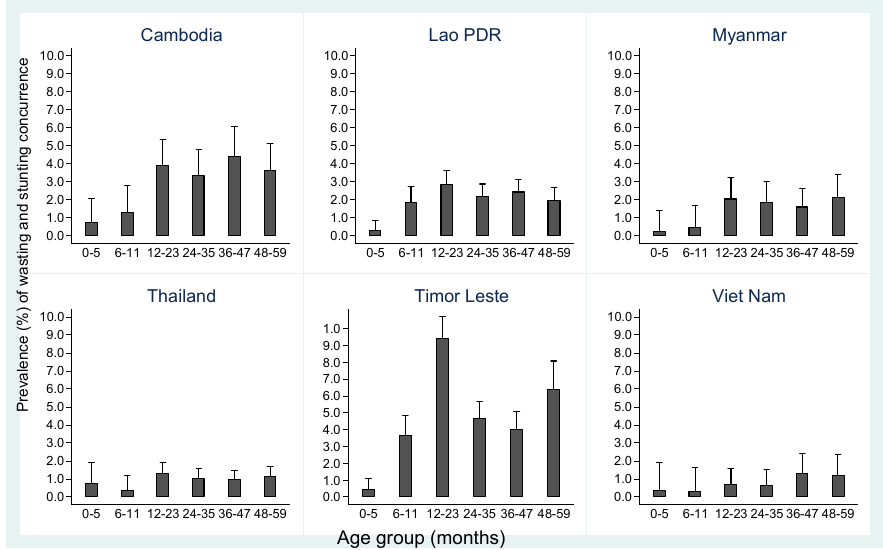
Figure 3. Prevalence concurrence of wasting and stunting by country and age groups.